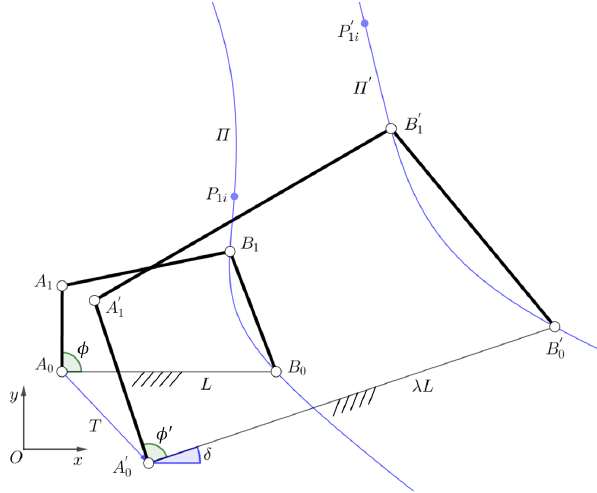
Figure 3. Geometric similarity transformation of rigid-body mech-